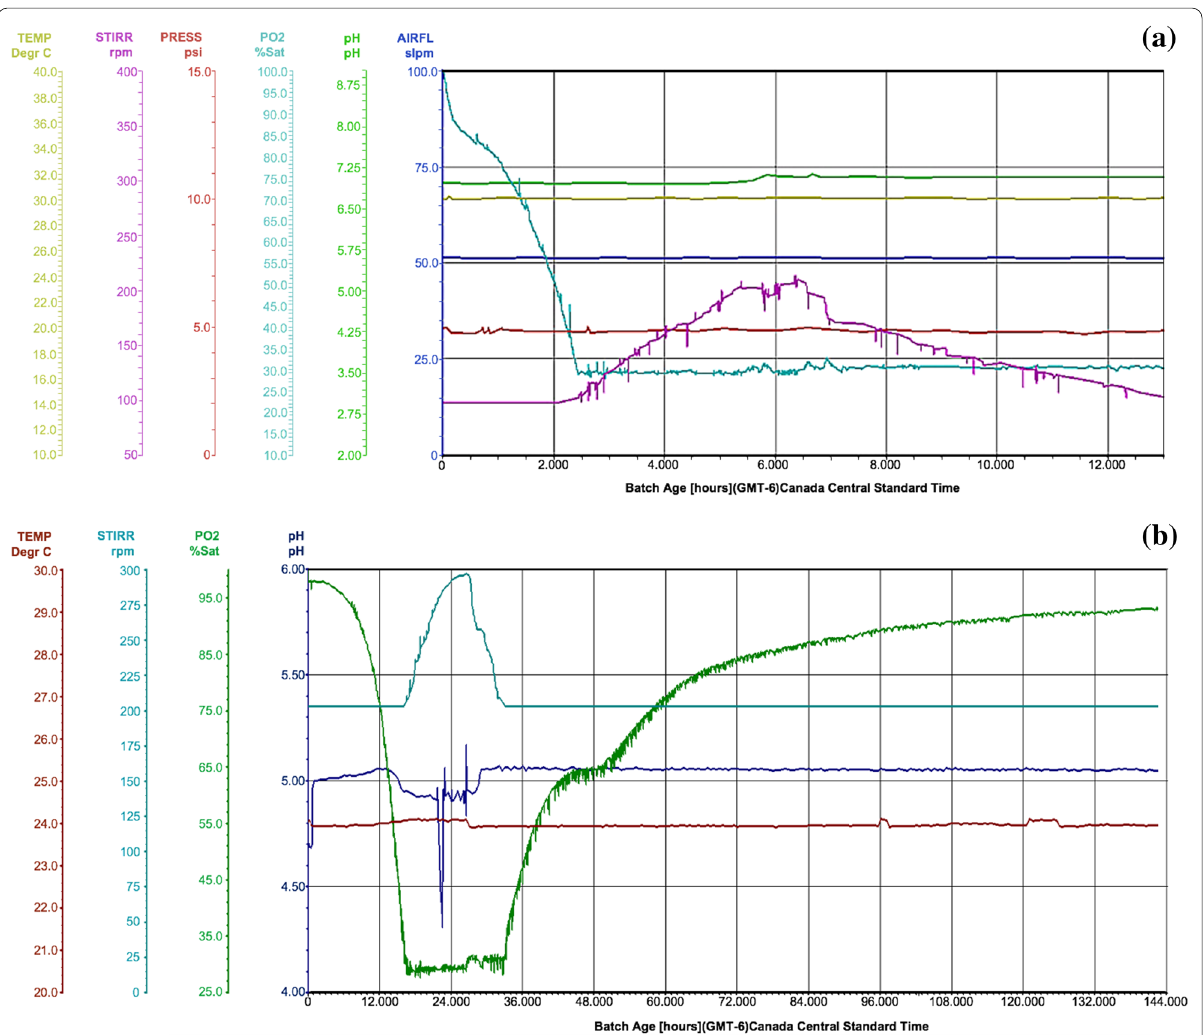
Fig. 3 Typical SCADA plot generated during a scale-up fermentation run for a a bacterial endophyte Streptomyces sp. SMCD strain, b a fungal plant endophyte Penicillium sp. SMCD